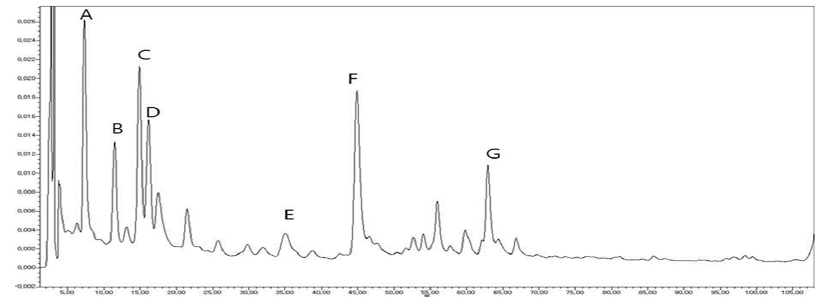
Figure 3. HPLC chromatogram of Nigella sativa 70% ethanolic extract. Quercetin-3-gentiobioside ( A ), nigelflavonoside B ( B ), quercetin sphorotrioside ( C ), nigelloside ( D ), kaempferol-3,7-diglucoside ( E ), rutin ( F ), and kaempferol 3-O-rutinoside ( G ).